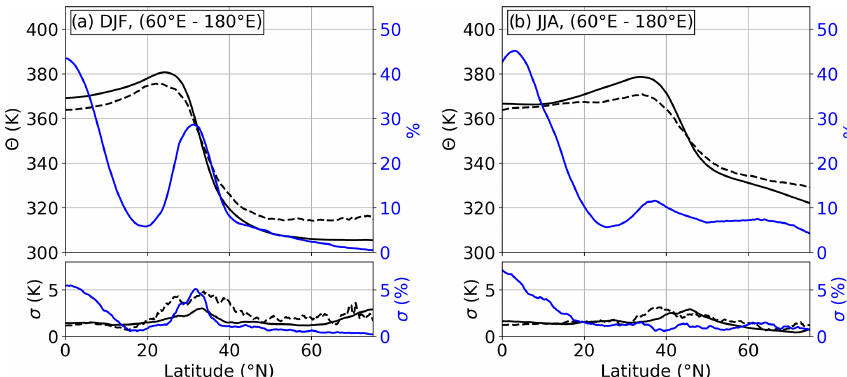
Figure 11. Vertical cross sections of 10-year average tropopause properties between 60 and 180 ◦ E longitude: (a) winter (DJF) and (b) summer (JJA). Upper panels: solid black line shows (cid:50) (LRT) for the zonal region. Solid blue line shows zonally averaged occurrence frequency for S 2 ≥ S 2 t between 1km below and 2km above the local LRT, and dashed solid line depicts (cid:50) (LRT) for such vertical profiles. Bottom panels show interannual standard deviation for every measure. The standard deviation of the occurrence frequency displays absolute percentage values.